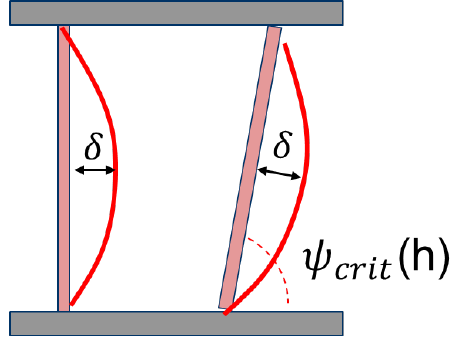
Figure 7. Fiber bending inside a gap during compression molding.